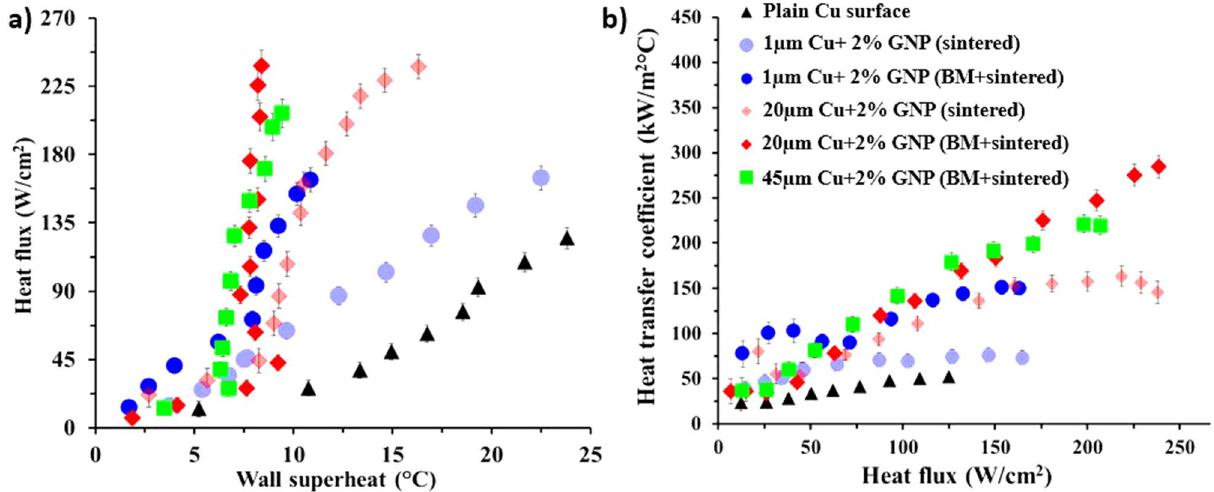
Figure 7. Comparison of the effect of ball milling and effect of copper particle size during GNP draping on pool boiling performance showing ( a ) heat flux versus wall superheat depicting pool boiling regimes, ( b ) heat transfer coefficient versus heat flux summarizing heat transfer